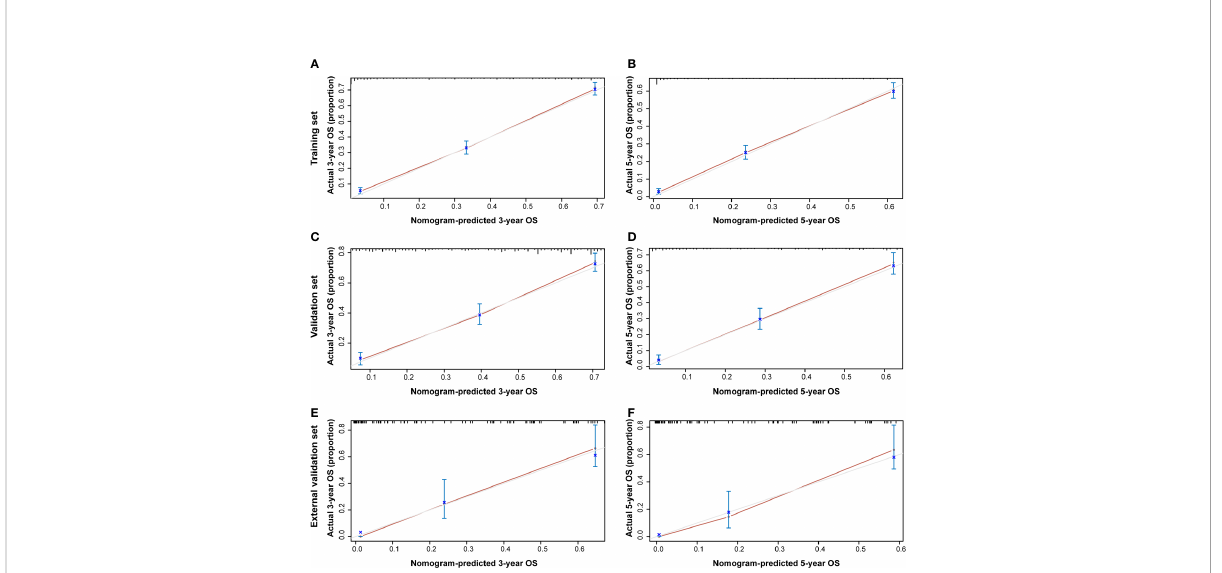
FIGURE 7 Calibration plot of the 3- and 5-year OS nomogram. The calibration curves of the 3-year (A) and 5-year (B) nomogram model for OS in the training set, respectively. The calibration curves of the 3-year (C) and 5-year (D) nomogram model for OS in the validation set. The calibration curves of the 3-year (E) and 5-year (F) nomogram model for OS in the external validation set.